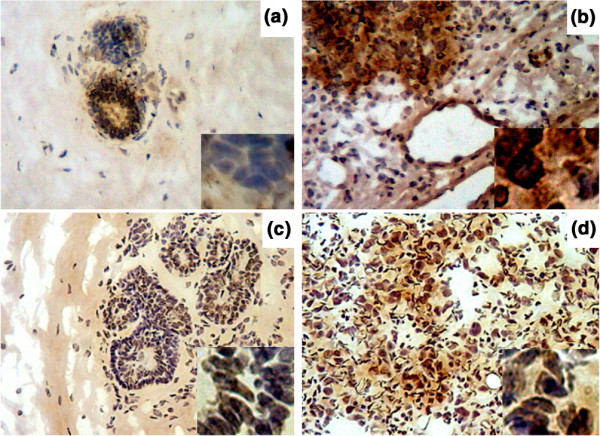
Immunohistochemical analysis of SDF1 and its receptor. Imunohistochemical staining of (a,b) SDF-1 and (c,d) the SDF-1 receptor CXCR4 in mammary tissues. The left panels show normal tissues, and the right panels show breast tumour tissues. CXCR, CXC chemokine receptor; SDF, stromal cell-derived factor.